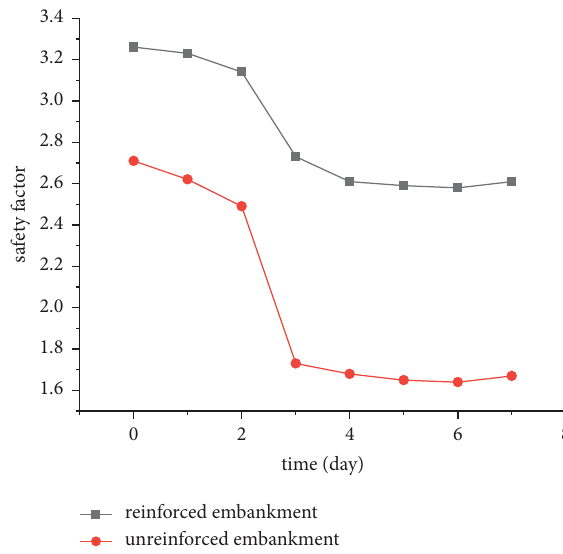
Figure 20: Slope safety factor of embankment changes over